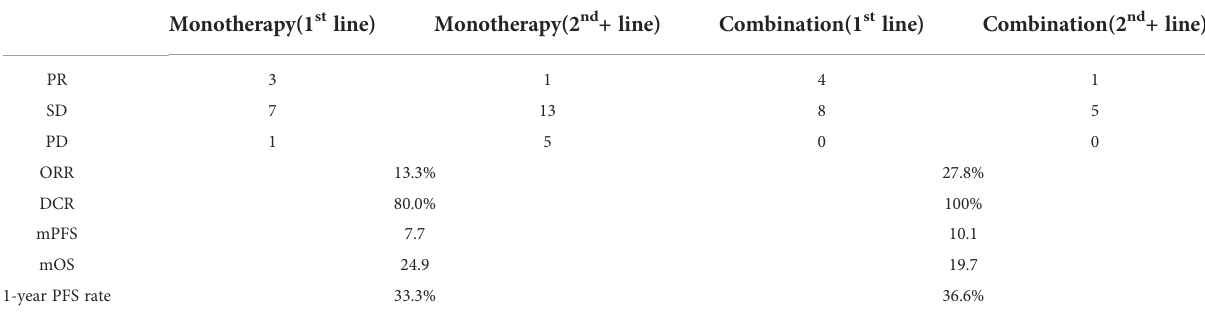
TABLE 2 Clinical responses of the 48 ICI-treated PLELC patients. Response Response to ICI